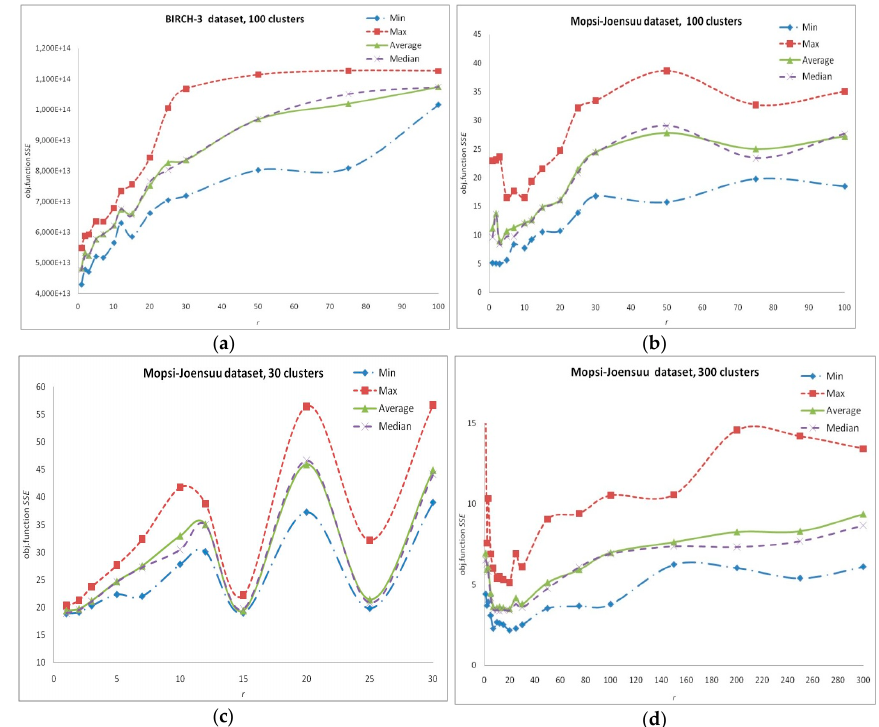
Figure 1. Search in SWAP r neighborhoods. Dependence of the result on r : ( a ) BIRCH3 data set, 100 clusters, 10 5 data vectors, time limitation 10 s; ( b – d ) Mopsi-Joensuu data set, 30, 100 and 300 clusters, 6014 data vectors, time limitation 5